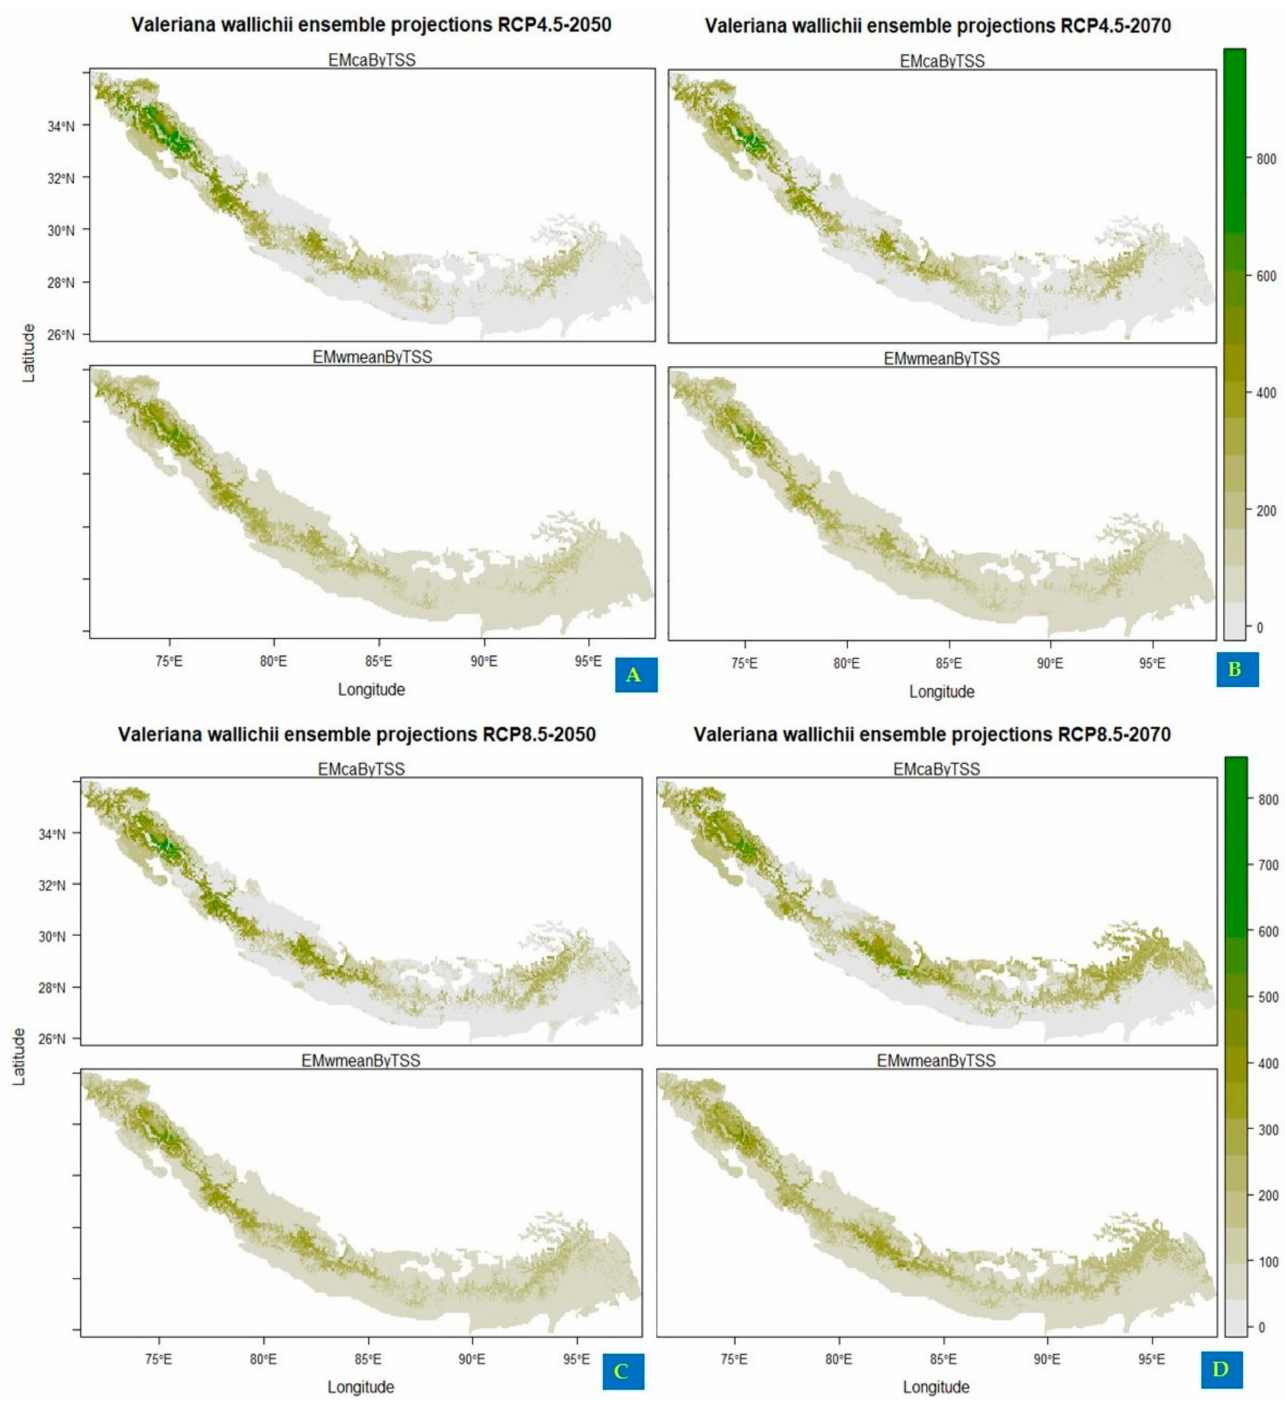
Figure 3. Future habitat distribution of Valeriana wallichii under projected climate change ( A , B ): show- ing the impact of climate change under representation concentration pathway 4.5 for two time periods, i.e., 2050 and 2070 ( C , D ): showing the impact of climate change under representation concentration pathway 8.5 for two time periods, i.e., 2050 and